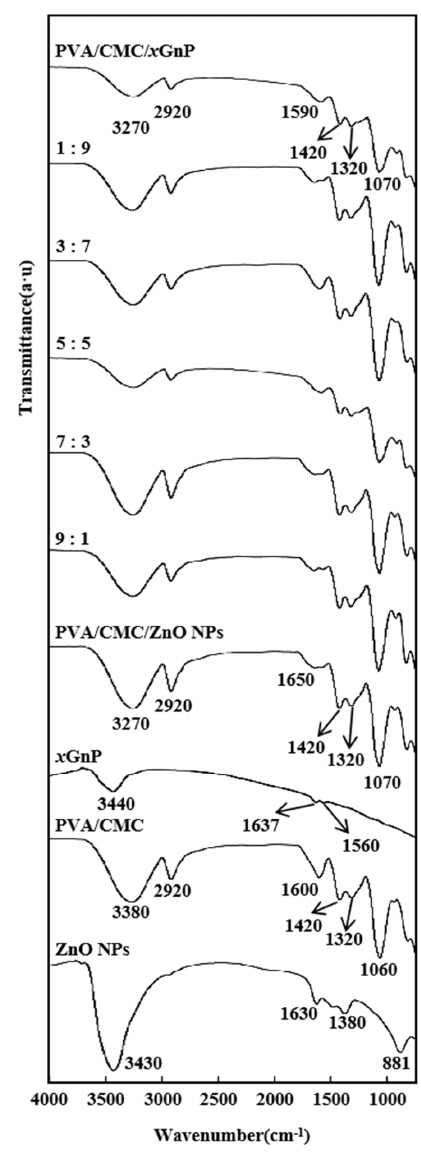
Figure 3. FTIR (Fourier Transform Infrared) spectra of ZnO NPs, PVA/CMC, x GnP, PVA/CMC/ZnO NPs, PVA/CMC/ZnO NPs/ x GnP (ZnO NPs: x GnP = 9:1, 7:3, 5:5, 3:7, 1:9) and PVA/CMC/ x GnP film without ultrasonication.